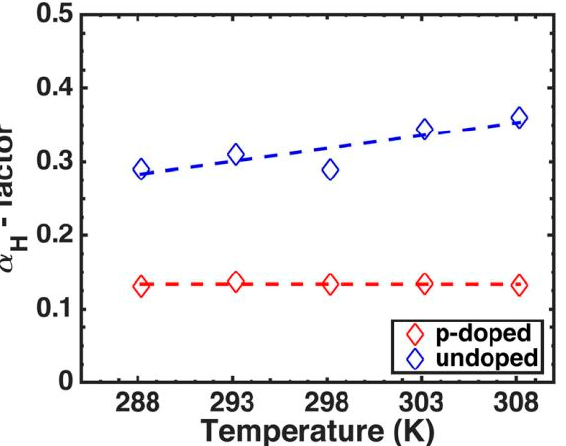
Figure 13. α as a function of temperature for p-doped and undoped QD lasers. Reproduced with permission from [108]. AIP Publishing, 2018.